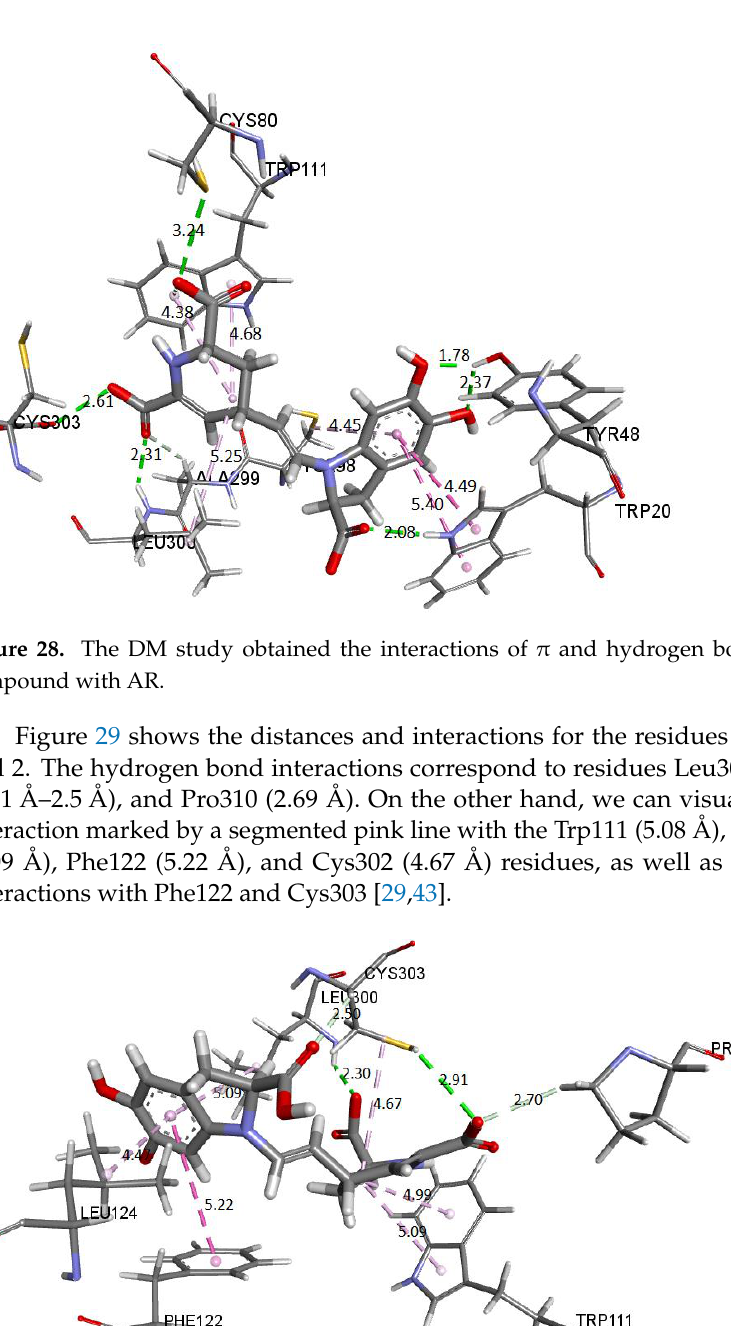
Figure 28. The DM study obtained the interactions of π and hydrogen bonds of the Li gand 1 com- pound with AR.